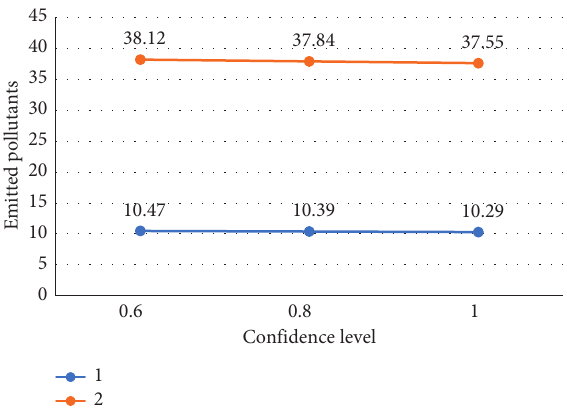
Figure 6: The value of emitted pollutants objective function for different confidence levels. Table 14: Comparison of the current and optimal status.